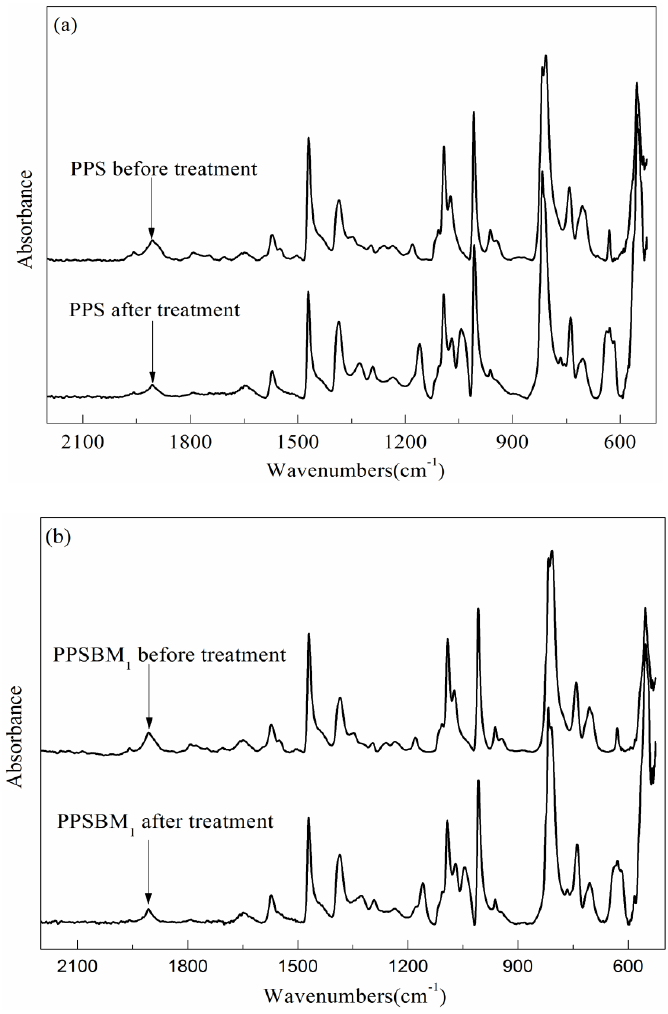
Figure 7. FTIR spectra of PPS ( a ) and PPSBM 1 composites ( b ) after the oxidation treatment. Table 2. Relative absorbance of PPS and PPSBM 1 composites before and after the treatment. Wavenumber (cm −1 )